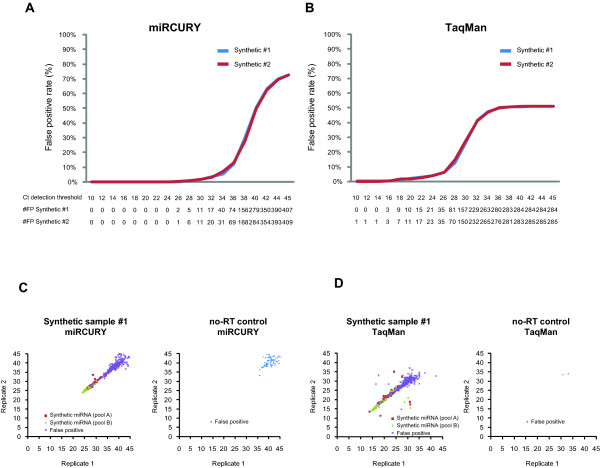
Assessment of the assay specificities of the miRCURY and TaqMan platforms. Utilizing the two synthetic samples #1 and #2 with known miRNA contents enabled us to investigate the false positive rate of the individual platforms at given Ct detection thresholds. The rates for the individual platforms are provided in (A) miRCURY and (B) TaqMan. Clearly, the number of false positives increased with increasing Ct detection threshold indicating that carefully chosen Ct detection thresholds could potentially reduce the number of false positives without affecting the true positives. In order to determine the thresholds for the two platforms the raw Ct's of the synthetic samples were compared to no-RT controls. As illustrated by plotting the raw Ct's for the duplicate measurements of the synthetic sample #1 and the no-RT-control for miRCURY (C) and TaqMan (D) thresholds set at Ct = 38 and Ct = 30, respectively would dramatically reduce the number of false positives. #FP, number of false positives.